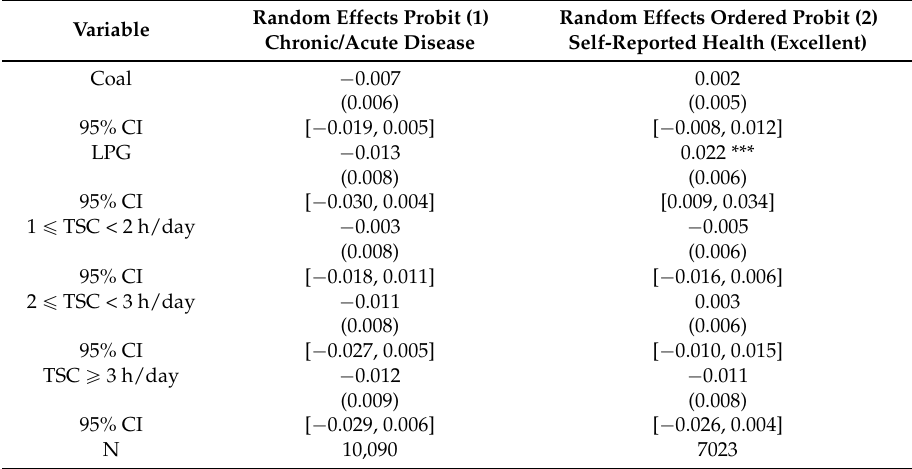
Table 5. Random effects (ordered) probit estimates for the effect of household cooking fuels on women’s health in rural areas: CHNS